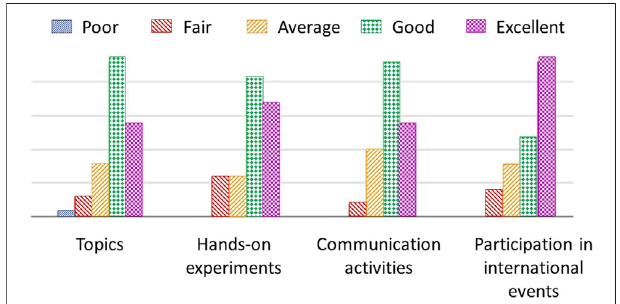
FIGURE 6 | Student evaluation of four aspects of the RM@Schools project: topics, hands-on experiments, communication activities, and participation in international events. The survey was completed by more than 20 classes, i.e., more than 500